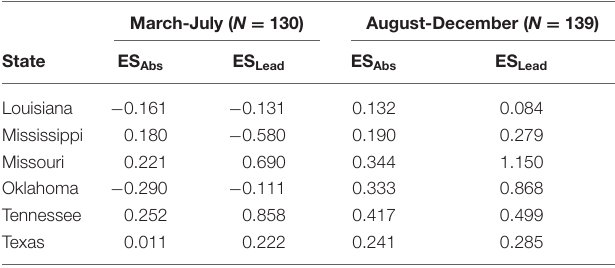
TABLE 3 | Comparison of March–July to August–December synchrony with